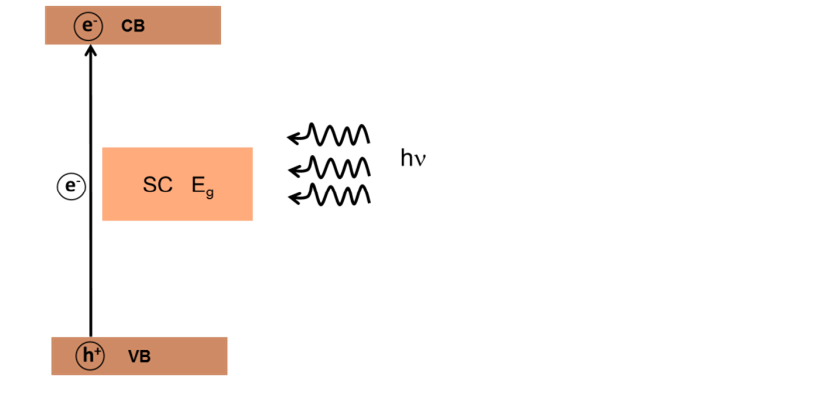
Figure 5 . Schematic representation of the formation of excited electron−hole